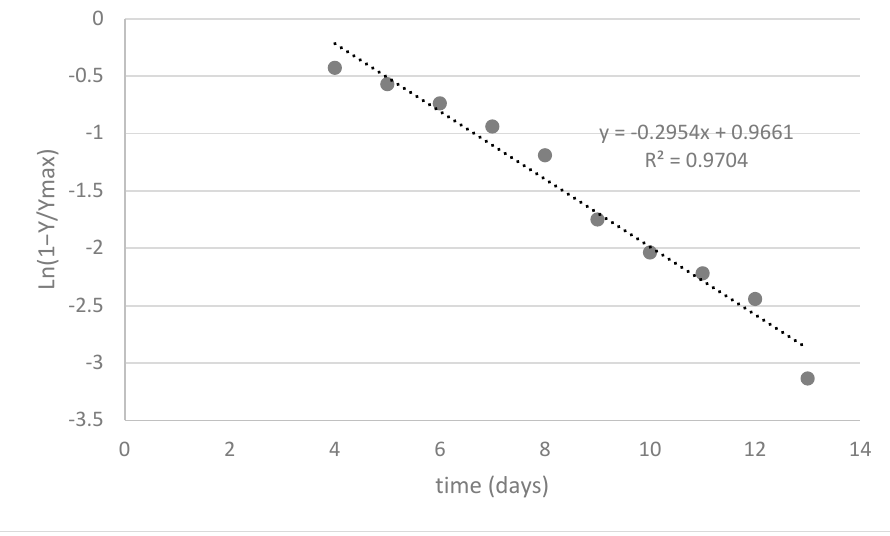
Figure 2. Plot revealing kinetic parameters for the L1.24 dataset.